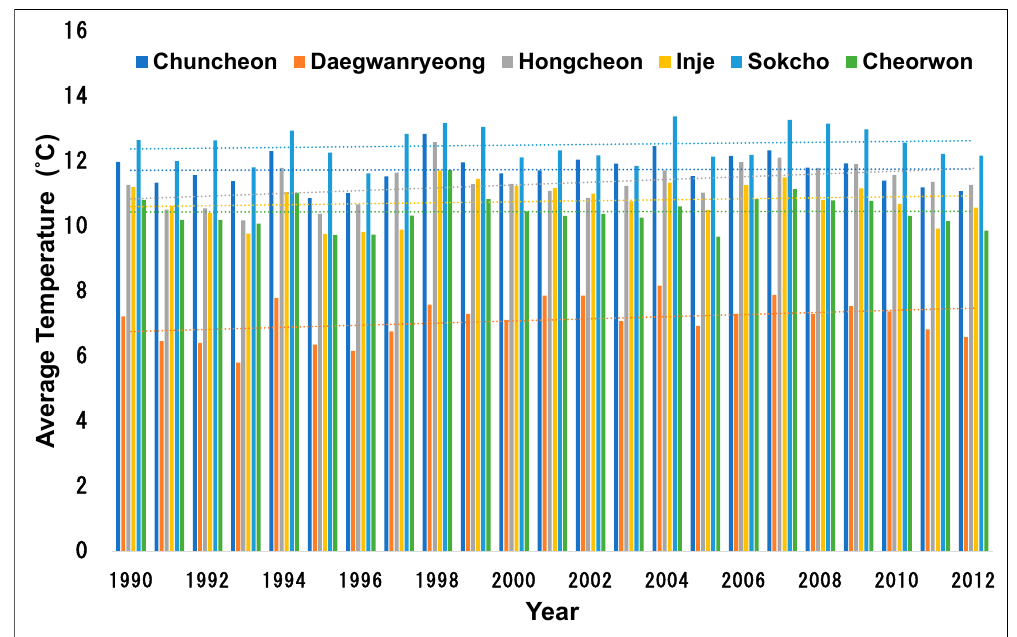
Figure 3. Annual average temperature at six weather stations (1990–2012).